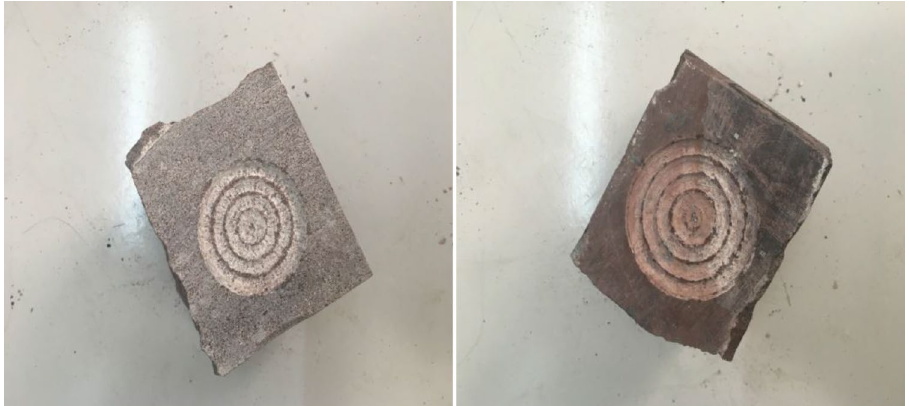
Fig. 2 Part of the experimental results of the